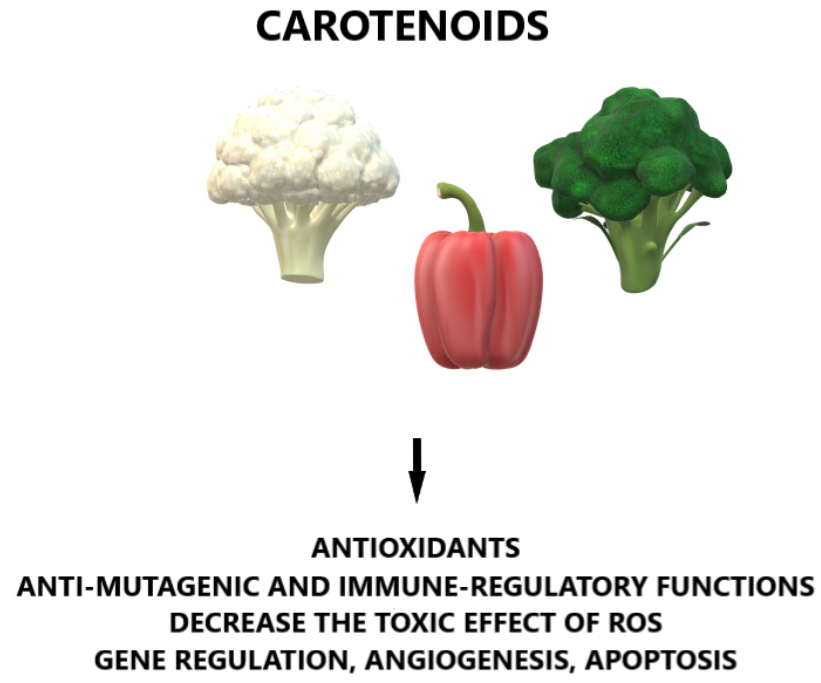
Figure 1. General effects of carotenoids. ROS: reactive oxygen species.